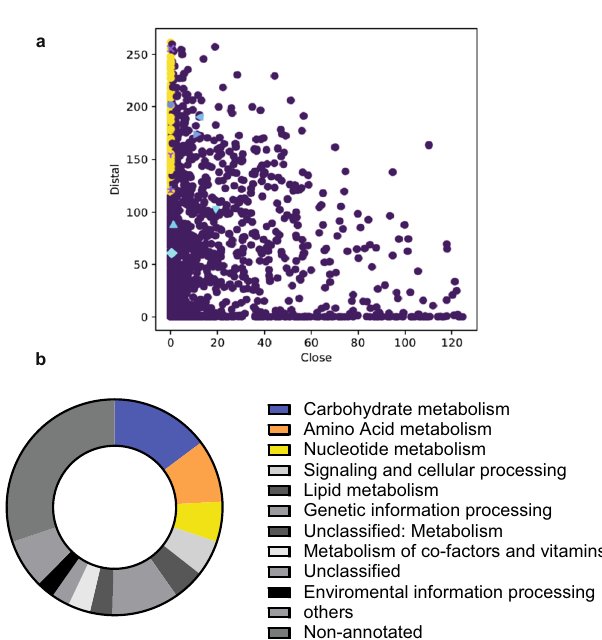
Fig. 3 | Automated prediction of gene transfers between Psyn and bacteria. a Plot indicating the distributions of “ close ” and “ distal ” scores revealed by simi- larity searches. ThescatterplotwascreatedwithHGTector.Potentially transferred genes ( n =149) are indicated in yellow, whereas the other coloured labels refer to Psyn folate-dependent enzymes (for annotation, see supplementary Figs. 2 and 3). b Distribution of the functional groups for potentially transferred Psyn genes obtained using the BlastKOALA annotation 29 .